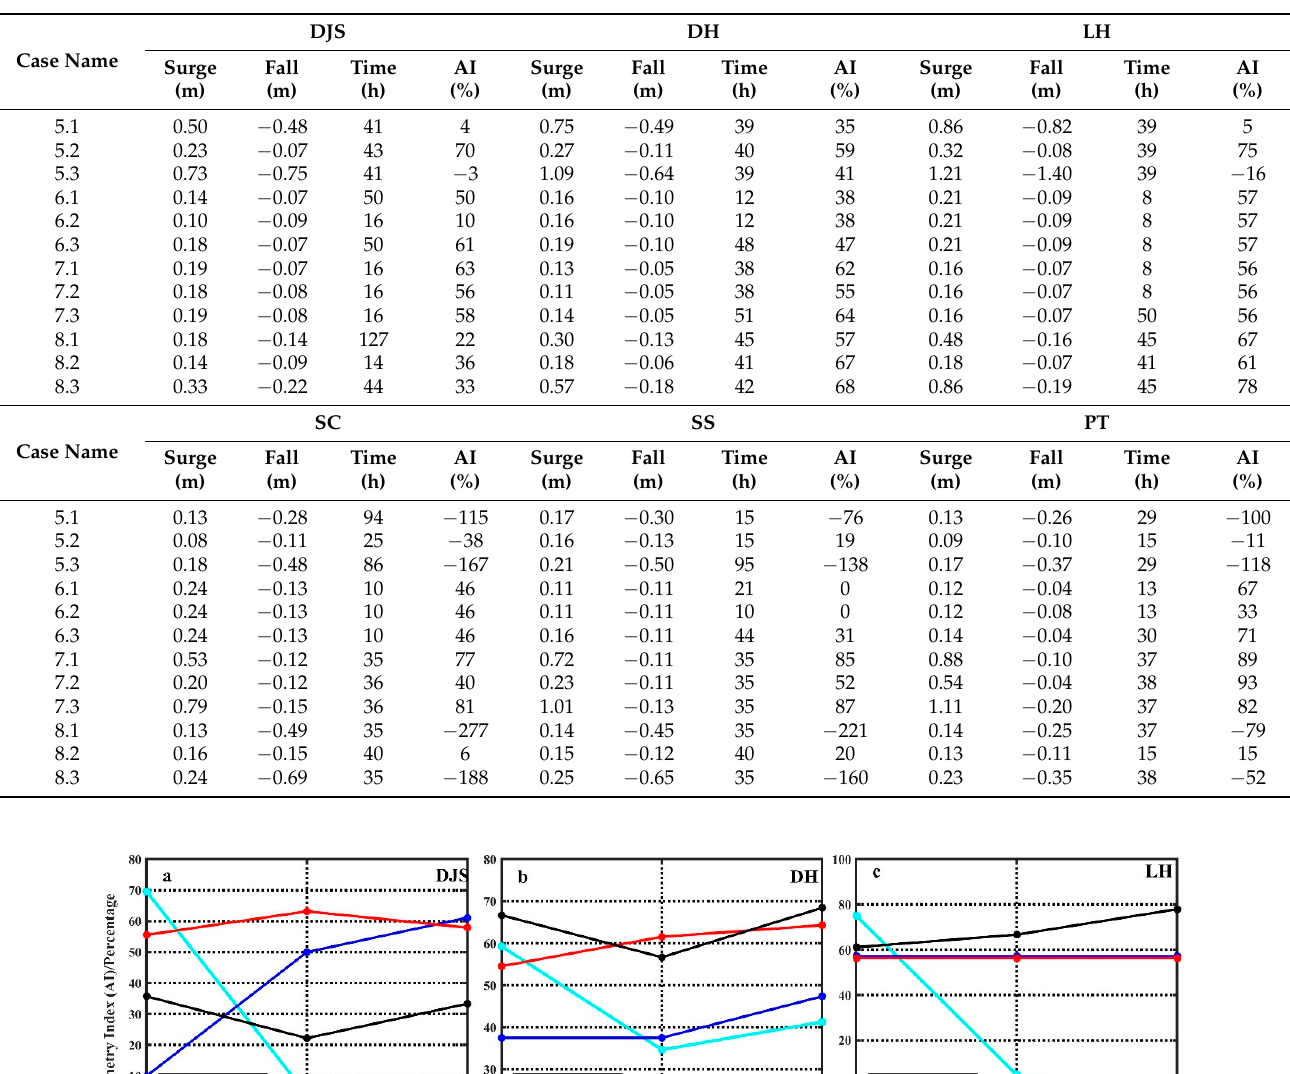
Table 8. The model results of surge, fall, time, and the value of AI in different wind intensity during four paths at six stations. Surge (m): Surge max ; fall (m): Fall max ; time: occurrence time of surge reaches the peak (from a cold start); AI: asymmetry index.